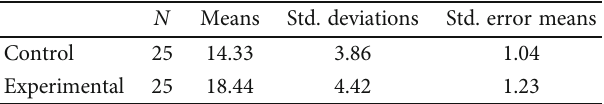
Table 4: Descriptive statistics of both groups in the speaking